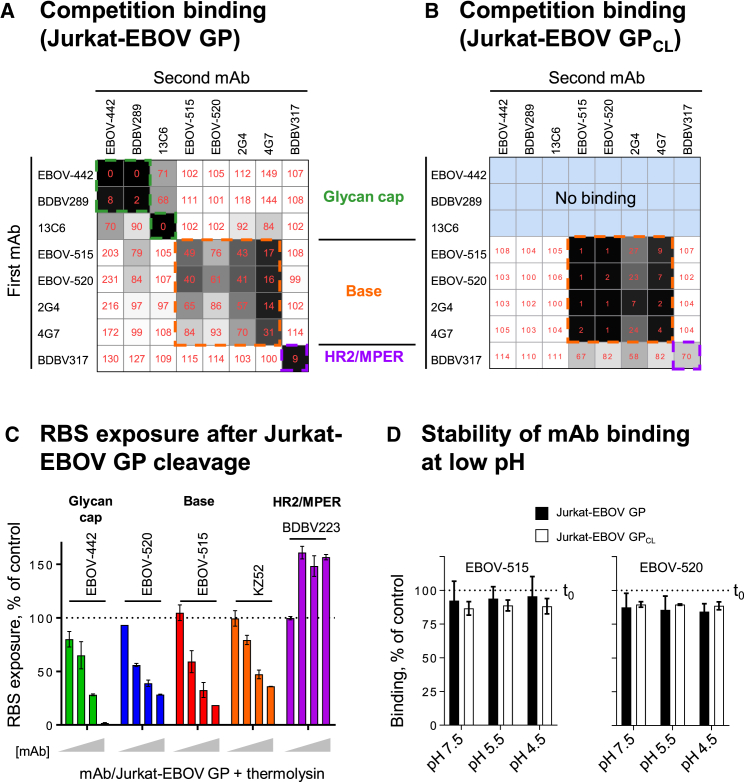
EBOV-515 and -520 Are Specific to the Base Region of GP and Possess a Capacity to Inhibit GP Cleavage(A and B) Identification of major antigenic sites for three bNAbs using a competition binding assay with intact Jurkat-EBOV GP (A) or thermolysin-cleaved Jurkat-EBOV GPCL (B). Cells were incubated with the first unlabeled mAb and then with the second fluorescently labeled mAb. Binding of mAbs was analyzed by flow cytometry. Numbers indicate the percent binding of the second fluorescently labeled mAb in the presence of the first unlabeled mAb, compared to binding of the second mAb alone.(C) Capacity of bound mAbs to inhibit the exposure of the RBS after EBOV GP to EBOV GPCL. Varying concentrations of mAbs (1, 10, 20, or 40 μg/mL) were incubated with Jurkat-EBOV GP, followed by cleavage and measurement of the exposure of the RBS with fluorescently labeled RBS-specific mAb MR78 by flow cytometric analysis. Dotted line indicates % RBS exposure in the presence of control mAb DENV 2D22.(D) Stability of mAb binding to Jurkat-EBOV GP or Jurkat-EBOV GPCL at neutral or acidic pH. Cells displaying GP or GPCL on the surface were fixed, pre-incubated with fluorescently labeled mAb at neutral pH, and then exposed to neutral or low pH for 60 min. mAb binding was assessed by flow cytometry. Stability of binding was expressed as the percent of the control (maximal binding) when cells were analyzed immediately after staining and without exposure to the neutral or low pH.Mean ± SD of triplicates are shown, and data are representative of 2–3 independent experiments. See also Figure S4.